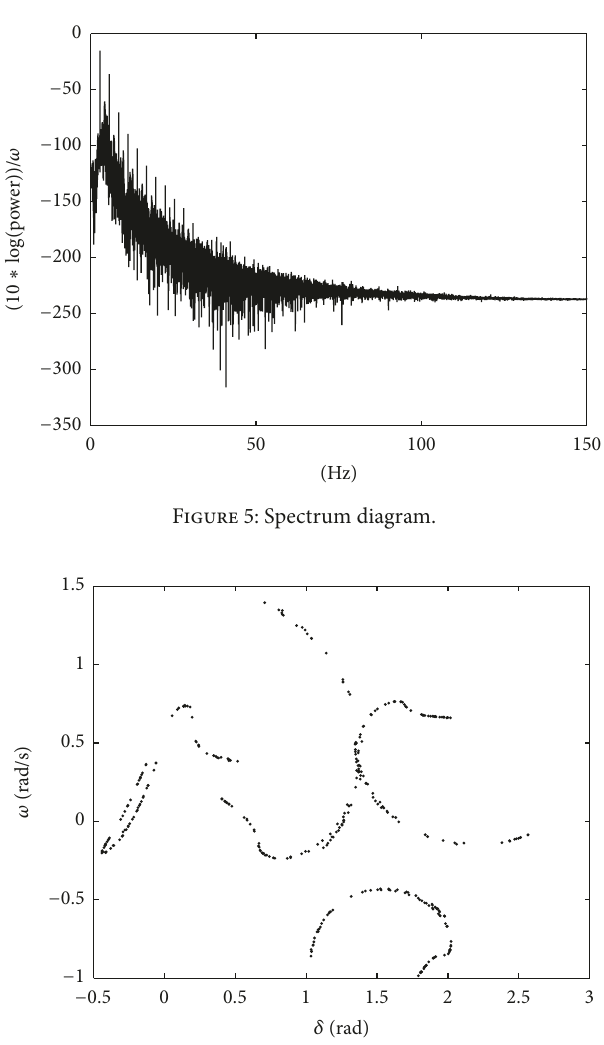
Figure 6: Poincare diagram.